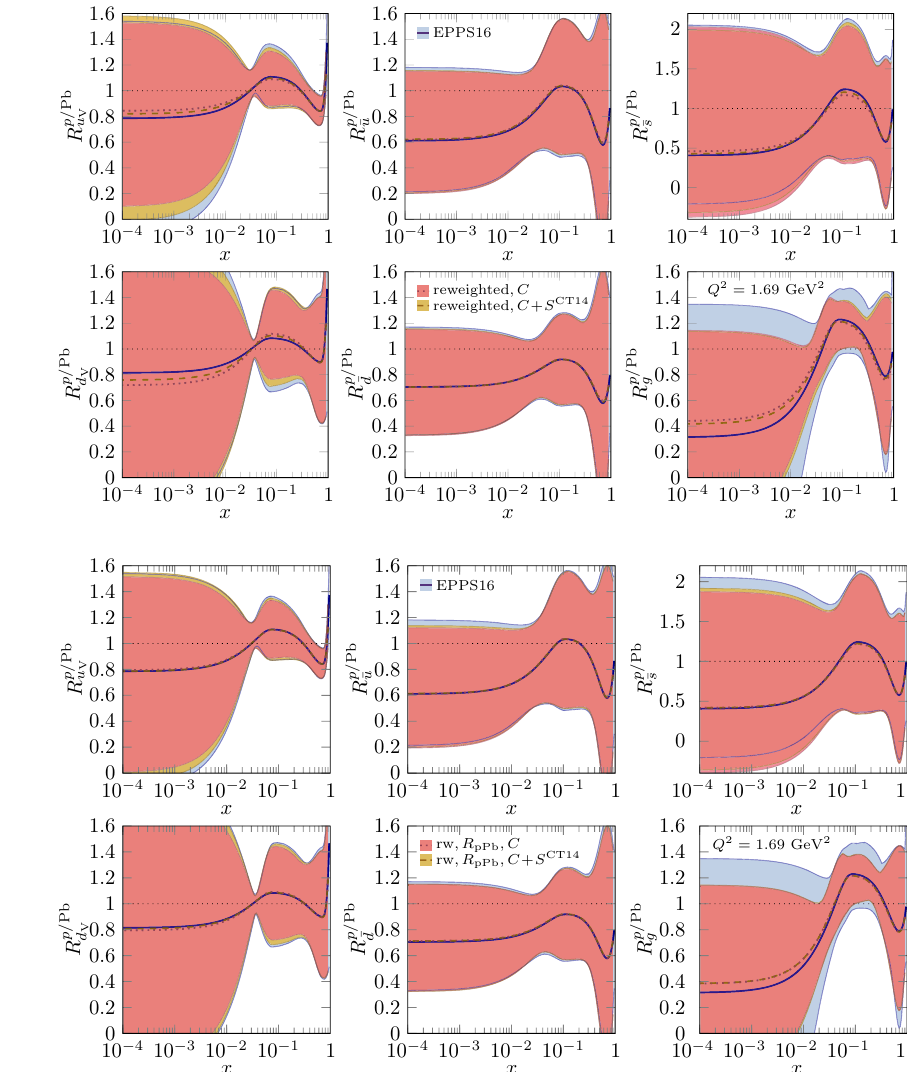
Fig. 15 As Fig. 14, but now for reweighting with the nuclear-modification ratios from Fig.